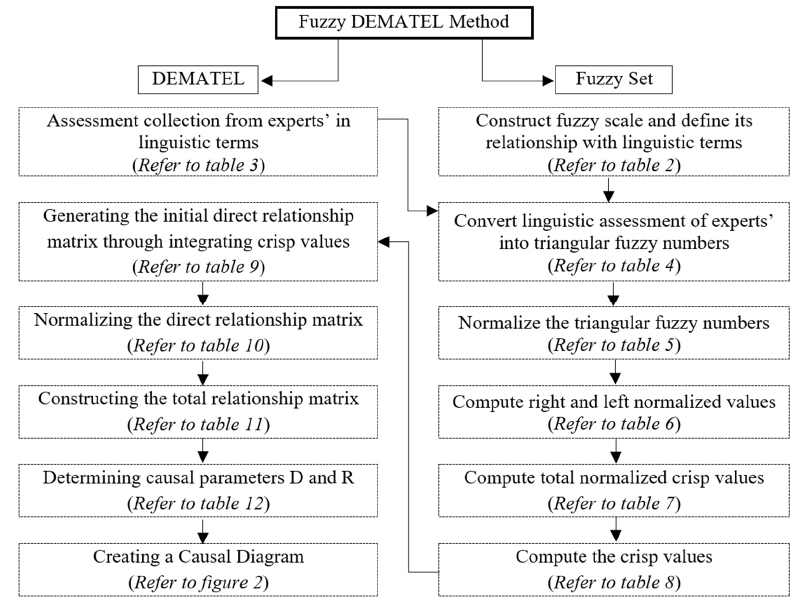
Figure 1. Linking of fuzzy set and DEMATEL for this